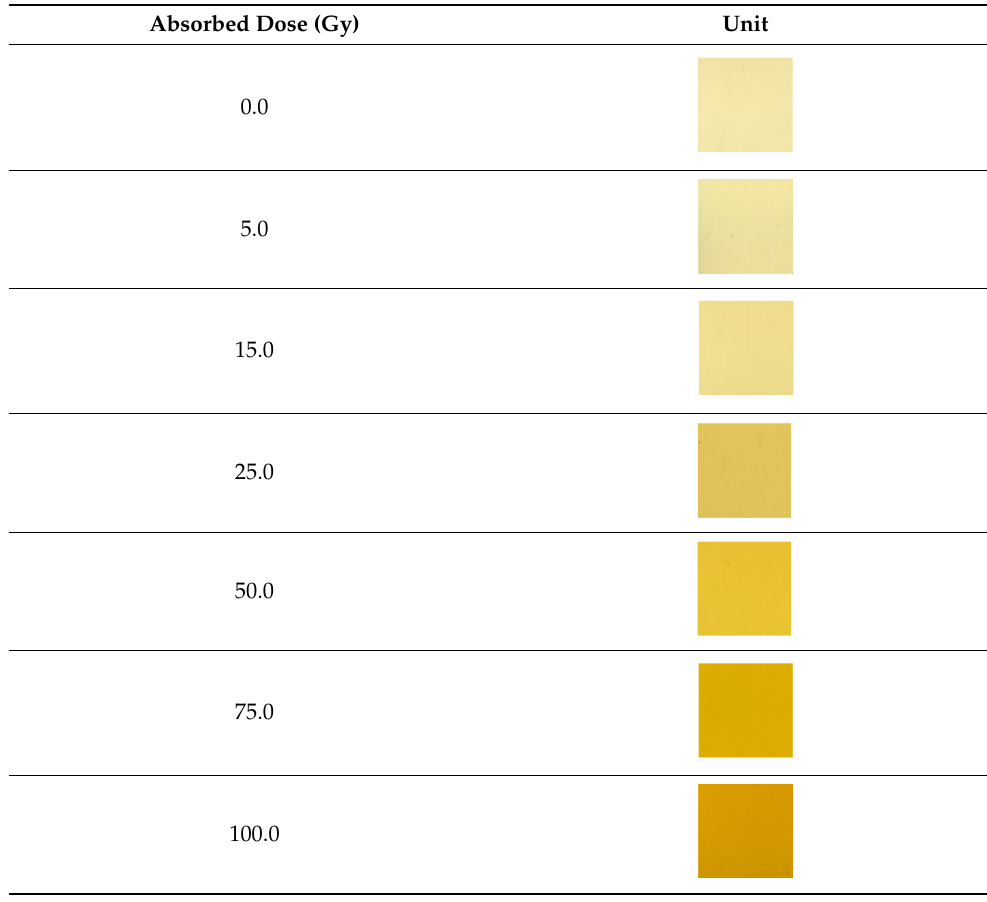
Figure 1. Optical absorption spectra of PAC hydrogel dosimeter unirradiated and irradiated at various absorbed dose values up to 100 Gy for PAC dosimeter with 100 mM AgNO 3 ( a ) and PAC dosimeter with 150 mM AgNO 3 ( b ). Table 1. Scanned images of silver nitrate hydrogel dosimeter (4% gelatin and 100 mM Ag) irradiated at different dose levels. An Epson Perfection V850 Pro scanner, made by Seiko Epson Corporation, was used to scan these